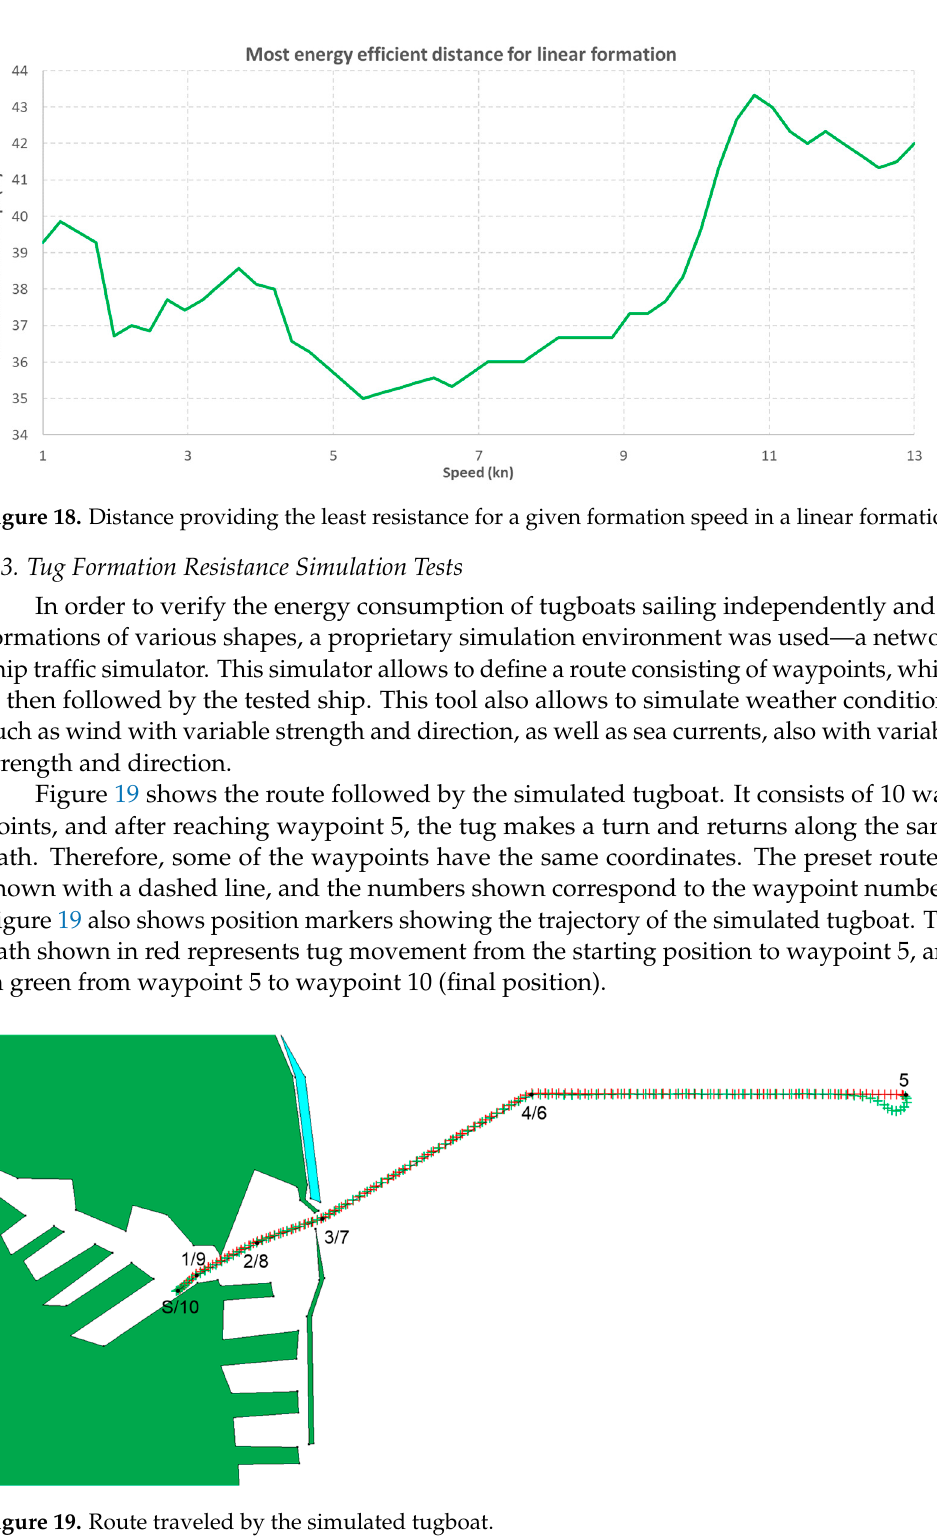
Table 4. Distances between successive turning points of the simulated route.